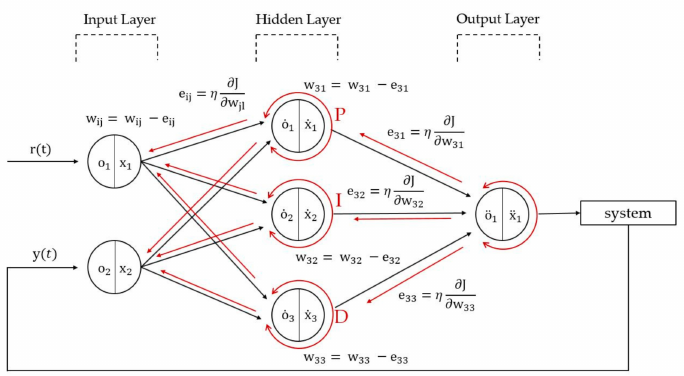
Figure 8. Schematic diagram of the PID neural network (PIDNN) controller back-propagation.